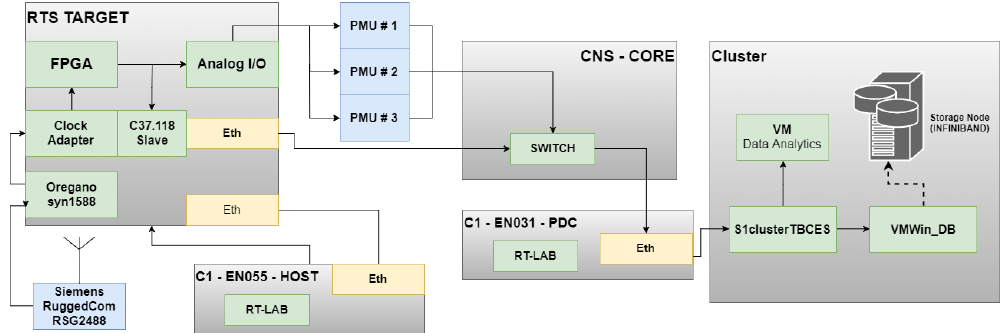
Figure 2. Synchronization and communication network setup for synchronized simulation and analog output to GPS